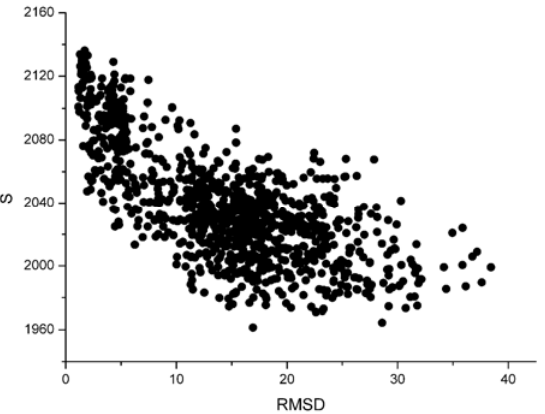
Figure 1. The relationship between the whole strength of the network (S) and the L_RMSD (The 1udi was taken as an illustration).